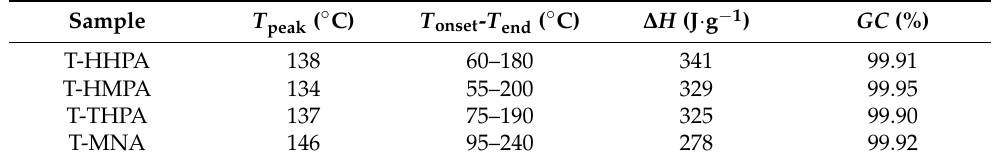
Table 2. DSC data of the epoxy-anhydride crosslinking and GC % obtained by solvent extraction method.